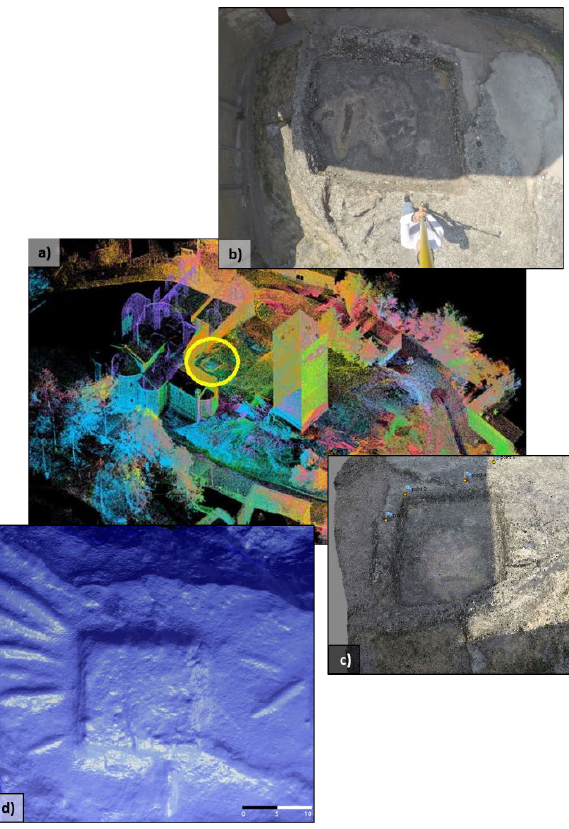
Figure 12. a) The location of the lithic bath near the Cathedral; SfM for the 3D reconstruction of the bath: b) an image acquired by GoPro Hero4 camera and c) the RGB point cloud; d) a